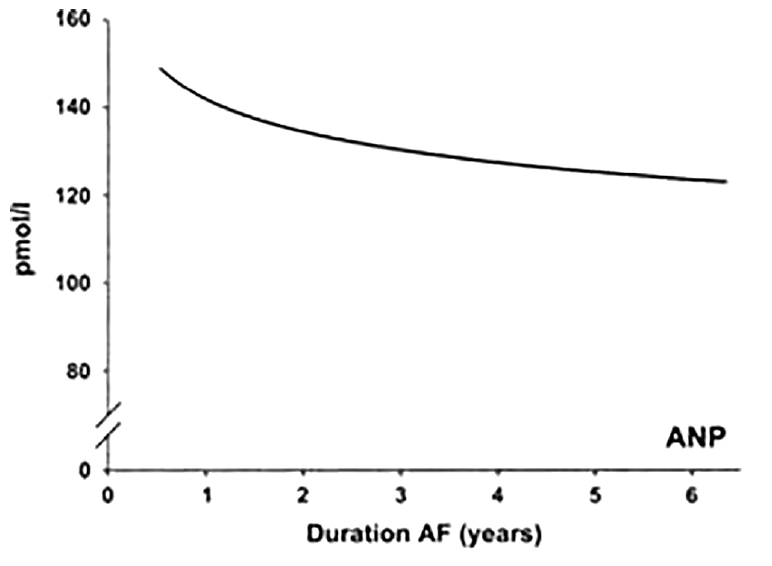
Figure 3. Correlations between the duration of atrial fibrillation (AF) and plasma concentrations of ANP